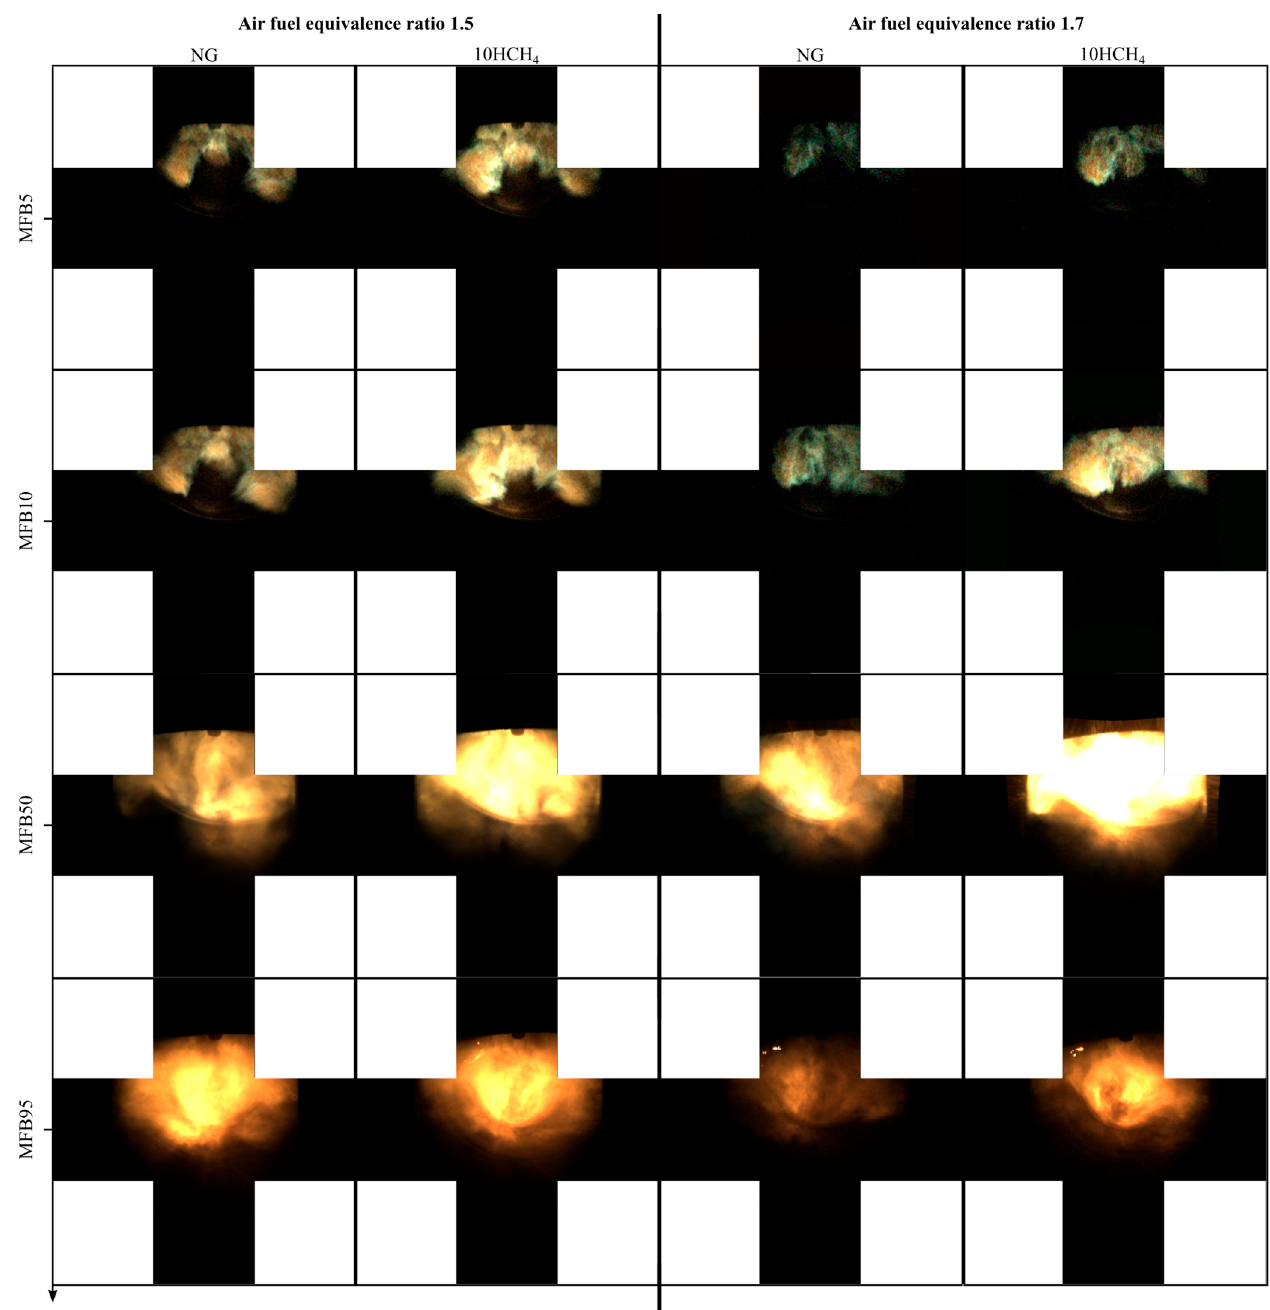
Figure 14. Combustion image series for MFB5, 10, 50 and 95 for the unscavenged pre-chamber spark plug at 8° CoC and air–fuel equivalence ratio of 1.5 and 1.7.